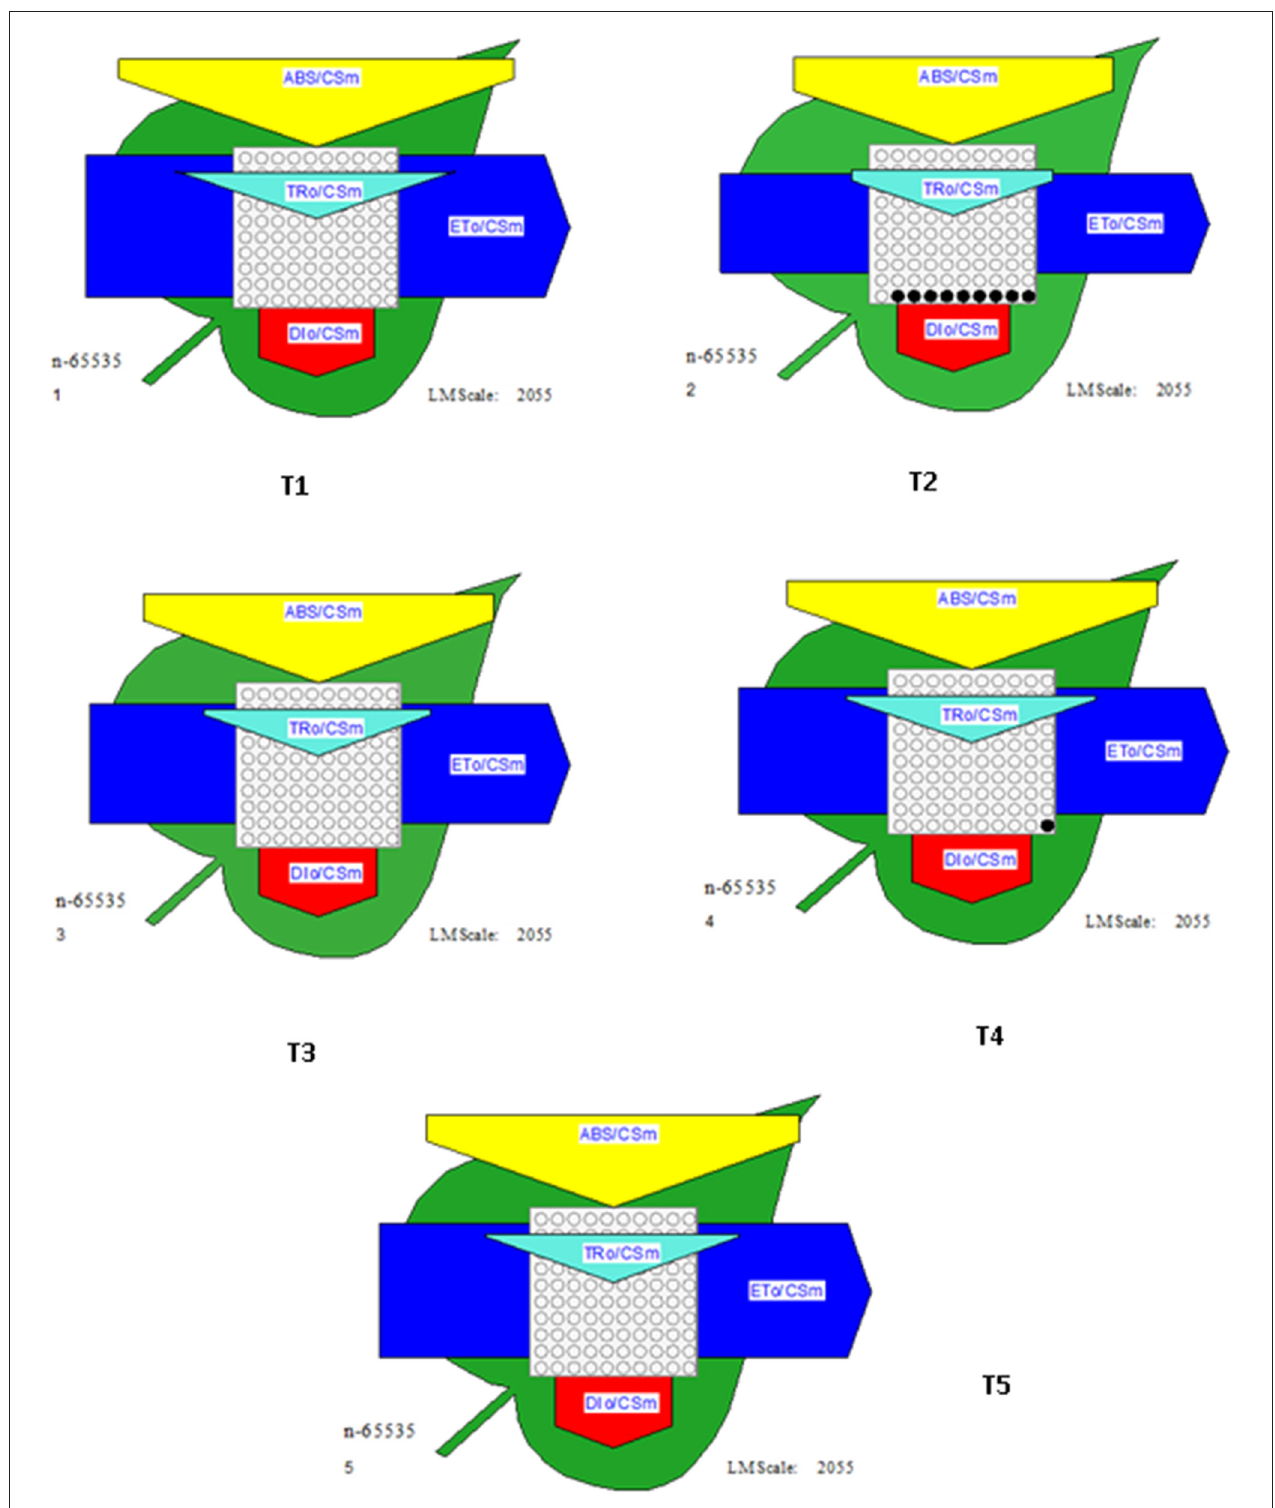
FIGURE 9 | Energy pipeline leaf model showing proportions of phenomenological energy flux parameters within a leaf, calculated per cross-section (CSm) in different treatments. The width of the corresponding arrow denotes the activity of that parameter. Empty and filled black circles indicate the percentage of active and inactive reaction centers of PSII, respectively. ABS/CSm, Absorption per cross section; TRo/CSm, Trapping per cross section; ETo/CSm, electron transport per cross section; DIo/CSm, Dissipation per cross section.